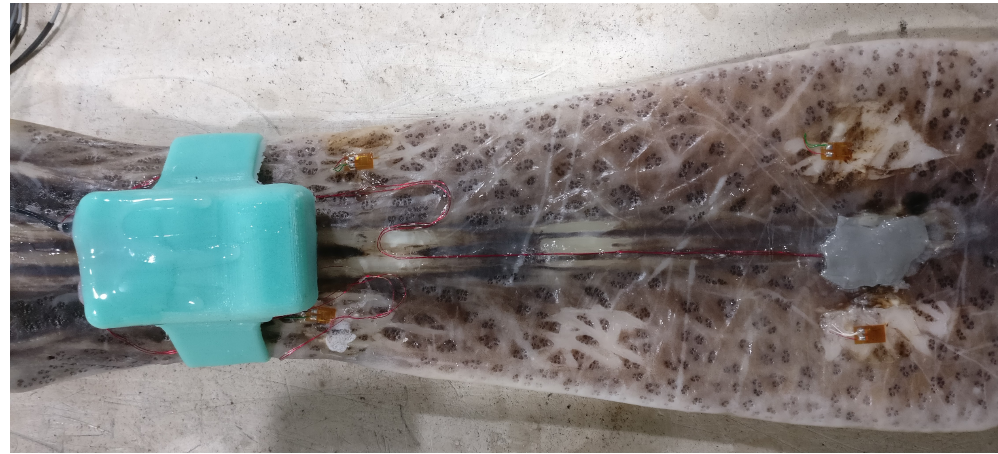
Figure 10. Bird’s-eye view of rostrum with instrumentation. Rostrum oriented posterior-anterior left-right. Dorsal strain gage is under the gray sealant, accelerometer, and data logger inside the turquoise silicone “watch